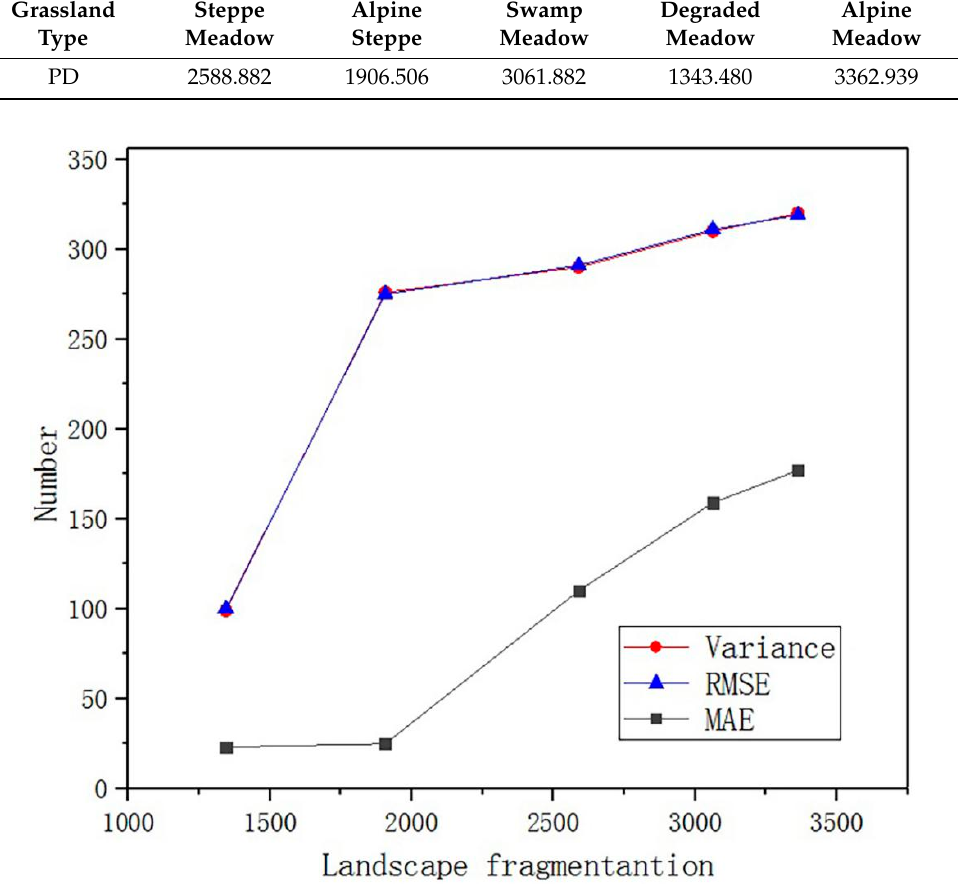
Figure 8. The relationship between the landscape fragmentation degree and the number of quadrats.